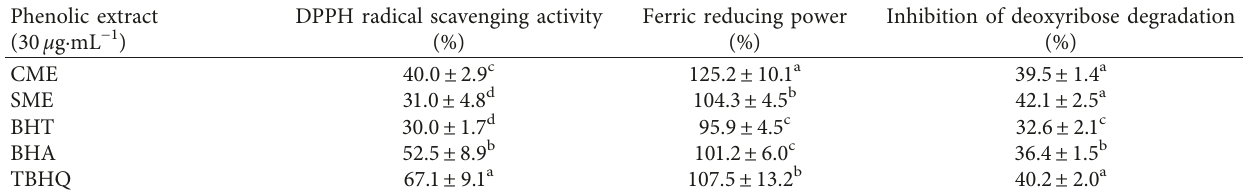
Table 1: Antioxidant activities of phenolic extracts and synthetic